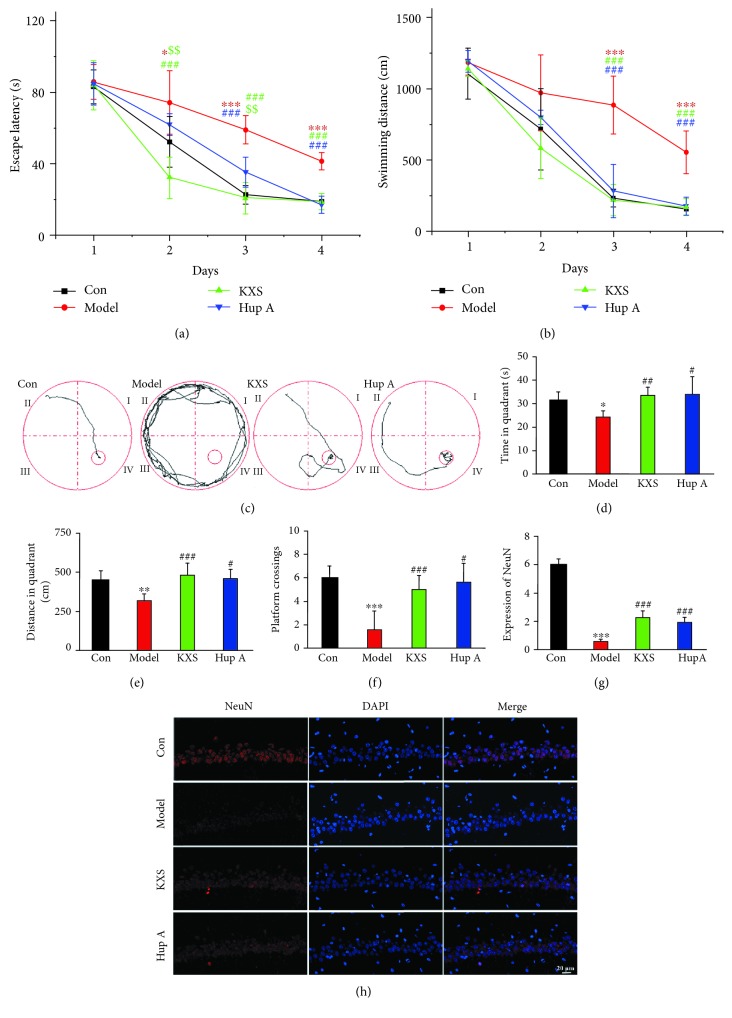
KXS treatment ameliorated memory and learning impairment. The mean escape latency (a) and swimming distances (b) were obtained from different test days, and the KXS group spent less time and distances to reach the fourth quadrant platform. Representative rat search paths from different groups (c) were shown on the fifth day. The rats treated with Hup A or KXS showed significantly less escape latency (d), swimming distance (e), and platform crossings (f) to find the removal platform in the fourth quadrant. Impact of KXS on modulating hippocampal NeuN levels was assessed by immunohistochemistry. The fluorescence intensity was quantified using Image-Pro Plus software (g and h). The treatment of KXS showed improvement in spatial memory. Values were the mean ± SD (n = 6). ∗
P < 0.05, ∗∗
P < 0.01, and ∗∗∗
P < 0.001vs. the control group; #
P < 0.05, ##
P < 0.01, and ###
P < 0.001vs. the model group; $$
P < 0.01vs. the Hup A group. Scale bar = 20 μm.